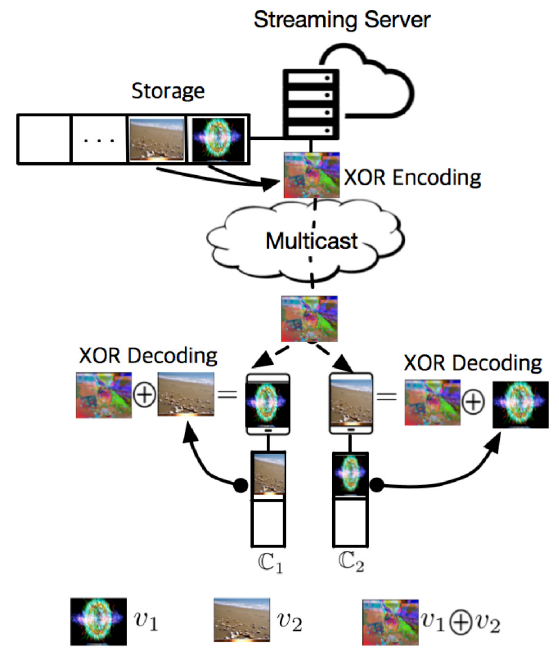
Figure 4. A conceptual illustration of video streaming using XOR-based coding